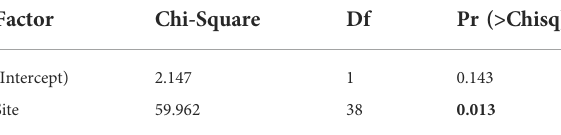
TABLE 2 Effect of “ Site ” on the number of detected residues.